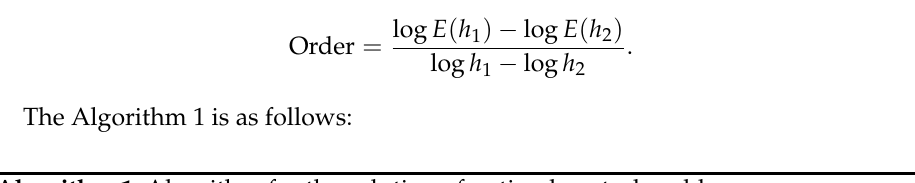
Algorithm 1: Algorithm for the solution of optimal control